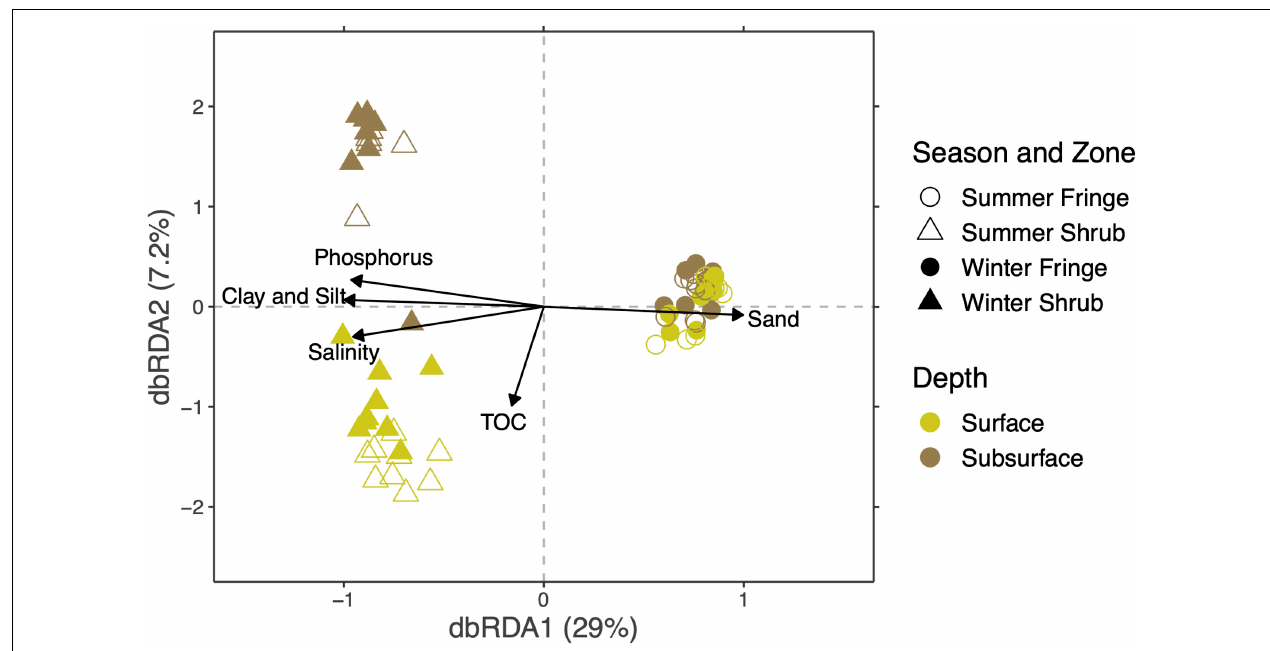
FIGURE 8 | Mangrove soil bacterial community sensitivity to environmental factors is presented by distance-based redundancy analysis (dbRDA, vegan package). The percentages given on the axes denote the variation explained by each dimension. Environmental factors grain size, salinity, total organic carbon, and phosphorus significantly explained 36% of the compositional variation in the